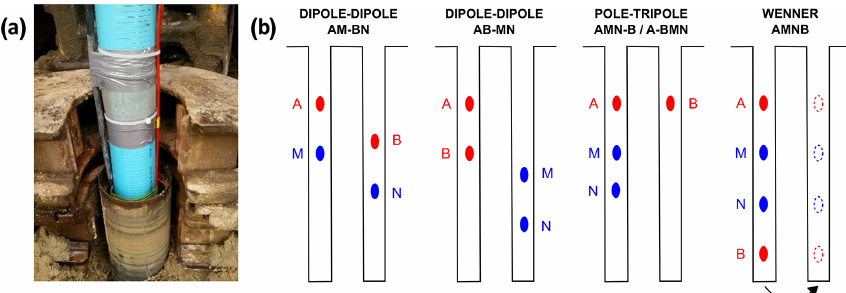
Figure 2. (a) Stainless-steel meshes (electrodes) permanently fastened around PVC piezometers for the time-lapse CHERT experiment during piezometer installation. (b) Electrode configurations used in the survey. A total of 5843 measurements are recorded per CHERT in less than 30min. Data are acquired sequentially by considering one pair of neighboring boreholes at the time. Four CHERT acquisitions are needed to build a complete CHERT, the whole 2D transect from boreholes N225 to